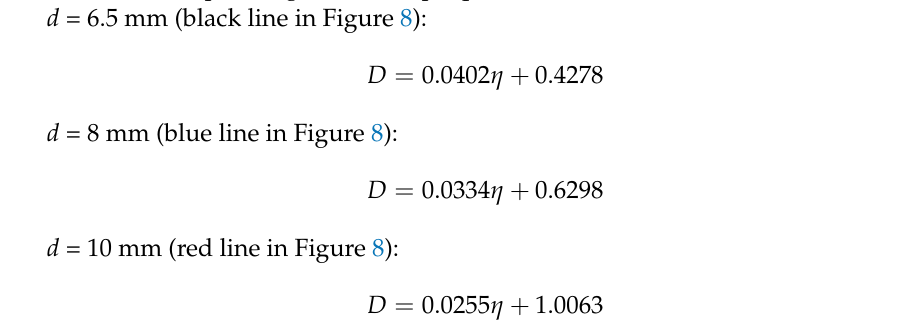
d = 6.5 mm (black line in Figure 8):